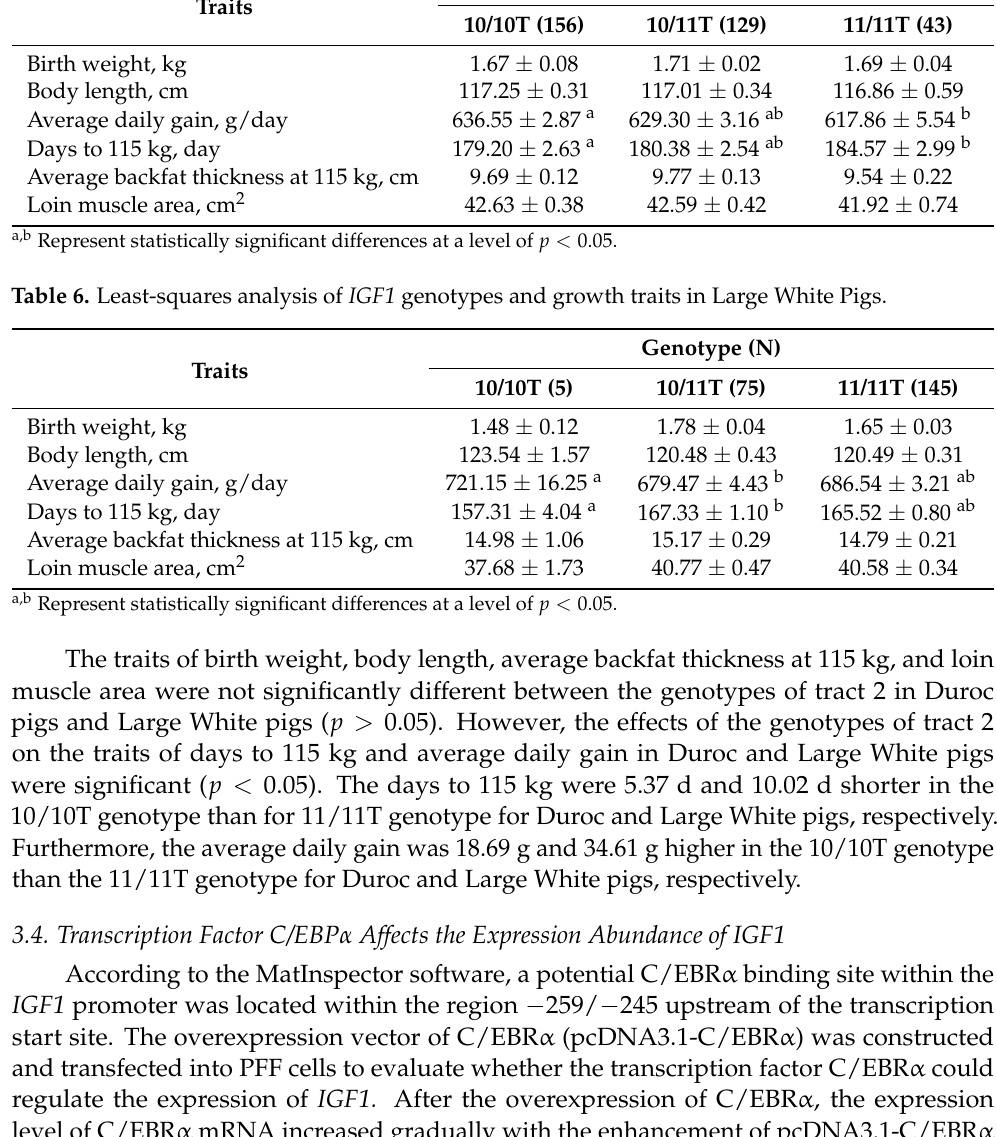
Table 5. Least-squares analysis of IGF1 genotypes and growth traits in Duroc Pigs. Traits Birth weight, kg